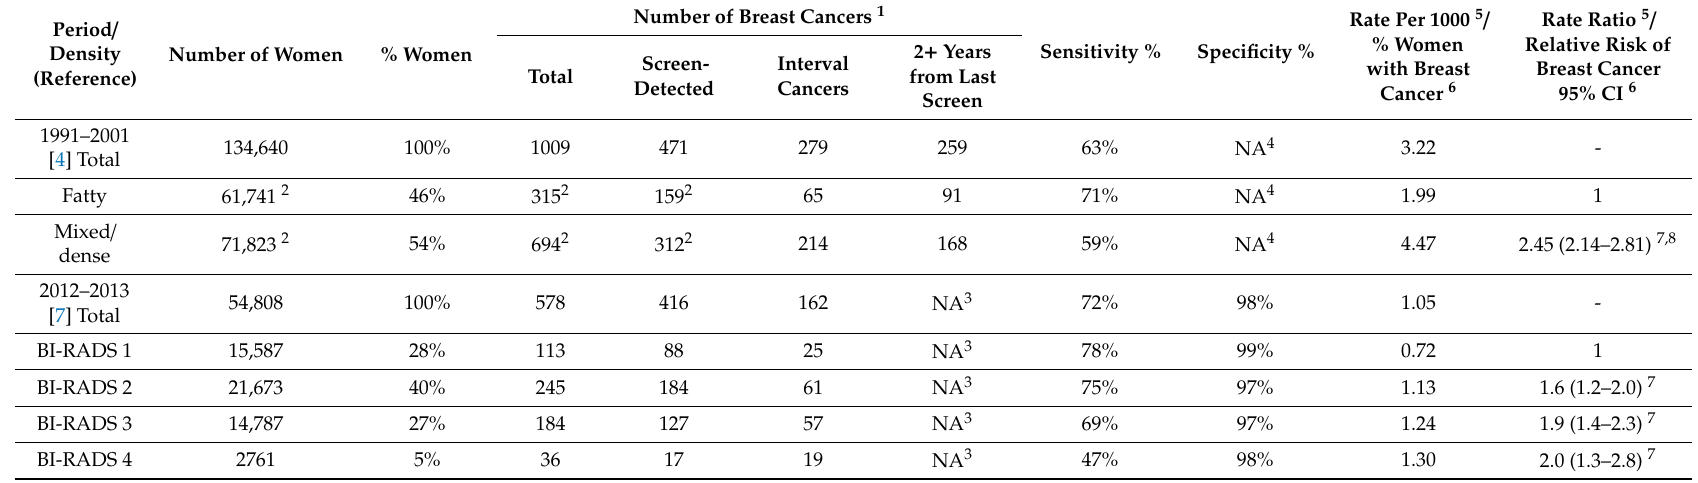
Note: 1 including ductal carcinoma in situ; 2 excluding cancers detected at first screening; 3 cohort followed for only 2 years after their last screen; 4 cannot be calculated, as the number of false positive screens were not tabulated; 5 rate per 1000 person years for 1991–2001; 6 proportion of screened women for 2012–2013; 7 age-adjusted; 8 person-years and cases accumulated based on last density category